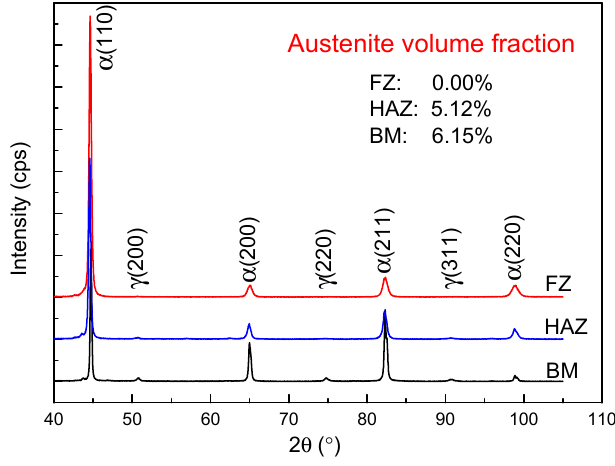
Figure 6. XRD results of the BM, HAZ and FZ.